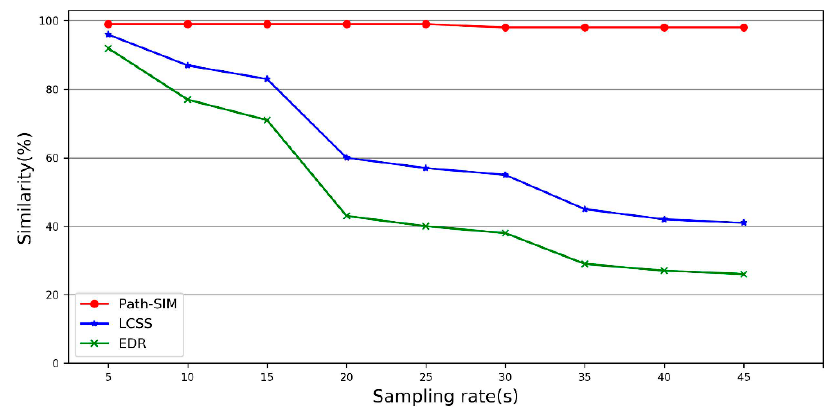
Figure 11. Performance evaluation for path similarity (Path-SIM), LCSS and EDR.